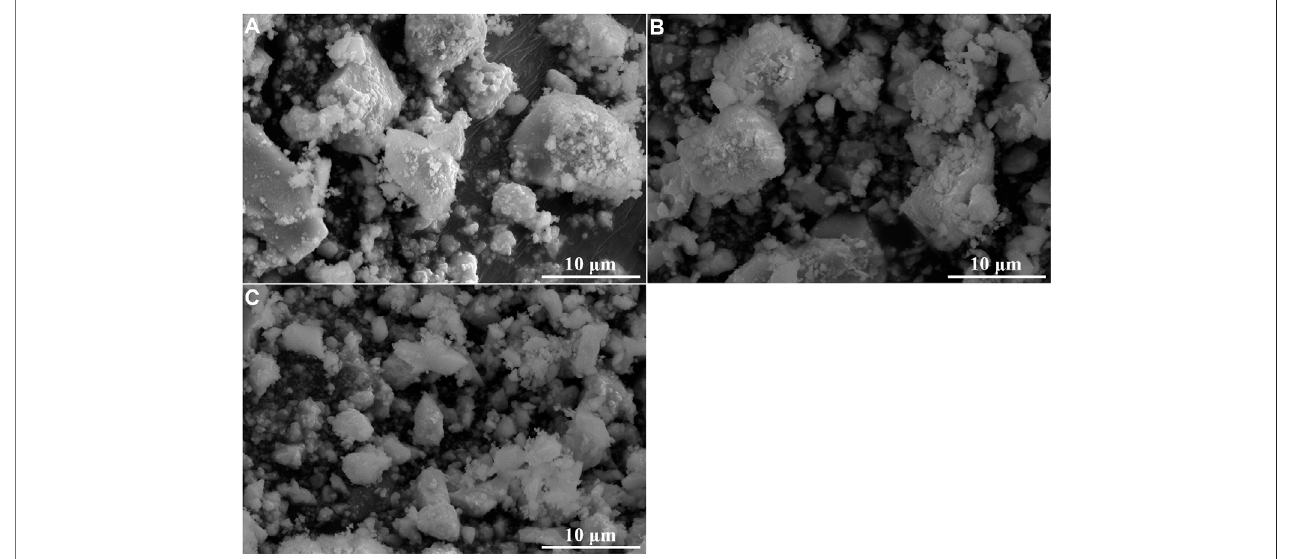
FIGURE 5 | SEM images of fi ltration residues obtained in solutions with La/F molar ratios of 1:3.10 (A) , 1:3.15 (B) and 1:3.20 (C) after reaction for 1 h.